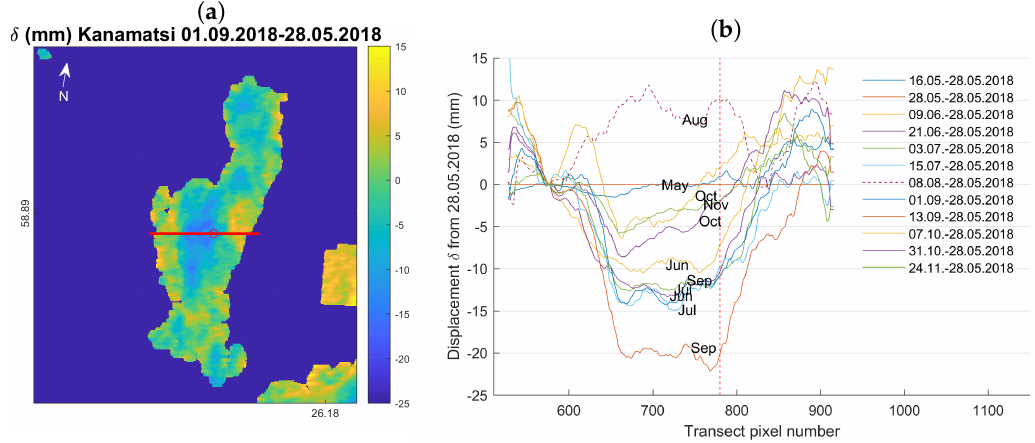
Figure 9. Kanamatsi area of open bog DInSAR displecement map (28 May–1 September 2018) ( a ) with a cross-section (red line) along which the elevation profiles were calculated; a black circle marks the location of control point for the single point time series (time series is shown in Figure 10). The temporal behaviour of the displacement along the transect is depicted on the right ( b ). As seen, central area of the bog has bigger dynamics along the profile than areas close to the edge of open bog. In principle, the profiles of displacement can have random offset due to atmospheric effects. However, here the profiles are leveled to a common tie-point. The vertical red dotted line marks the location of control point for the single point time series (time series is shown in Figure 10).